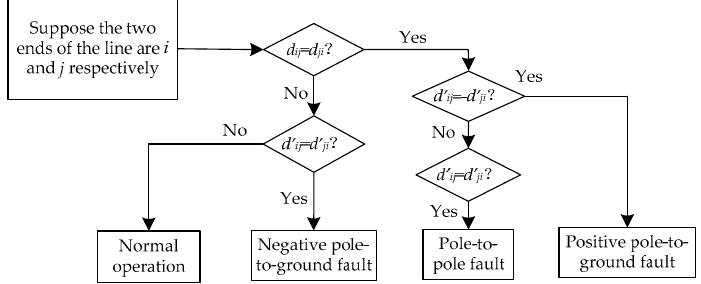
Figure 6. The algorithm flowchart of fault ‐ type identification.